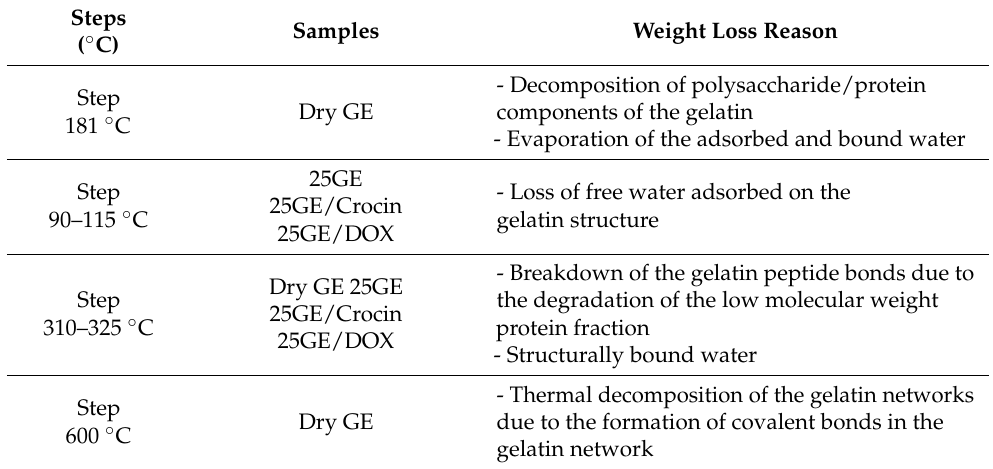
Table 4. Weight loss reason at the maximum peaks of temperature shown in Table